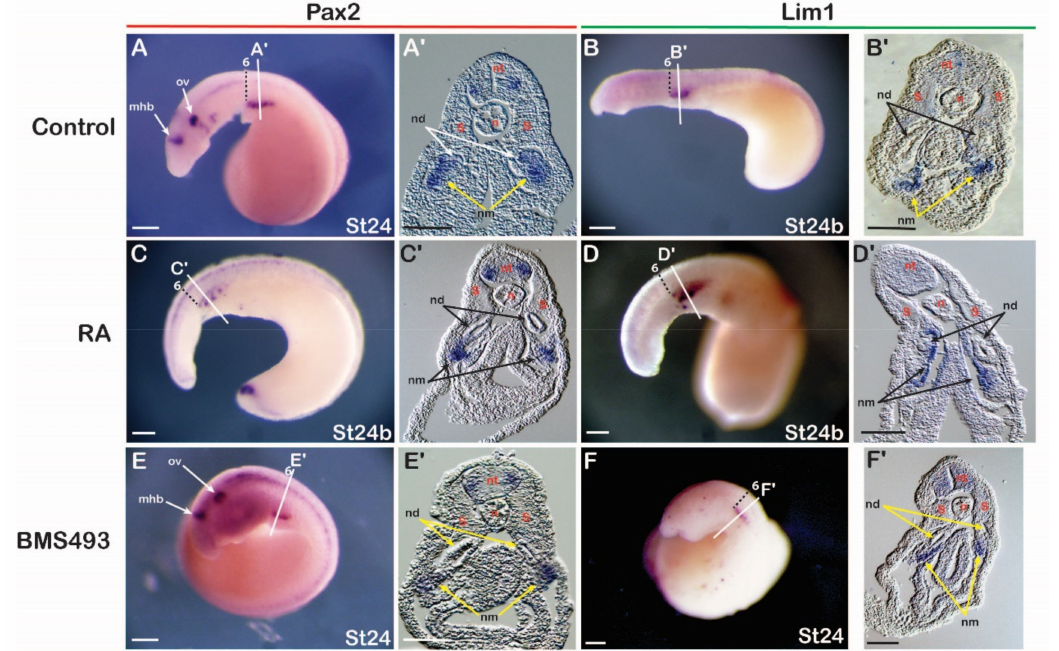
Figure 4. Retinoic acid signaling and the regulation of nephric genes in the lamprey. ( A , B ) Pax2 ( n = 20) ( A ) and Lim1 ( n = 20) ( B ) expression in control embryos. ( C , D ) Pax2 ( n = 15/15) ( C ) and Lim1 ( n = 13/15) ( D ) expression in embryos treated with retinoic acid (RA). ( E , F ) Pax2 ( n = 18/20) ( E ) and Lim1 ( n = 16/18) ( F ) expression in embryos treated with BMS493, an inverse agonist of retinoic acid receptors. Somites are marked by numbers. Cross sections are at the level of the lines in the whole mounts. mhb, midbrain-hindbrain boundary; n, notochord; nd, nephric duct; nm, nephric mesenchyme; nt, neural tube; ov, otic vesicle; S, somite; st, stage. Scale bars in ( A – F ) are 200 µ m and scale bars in ( A’ – F’ ) are 50 µ